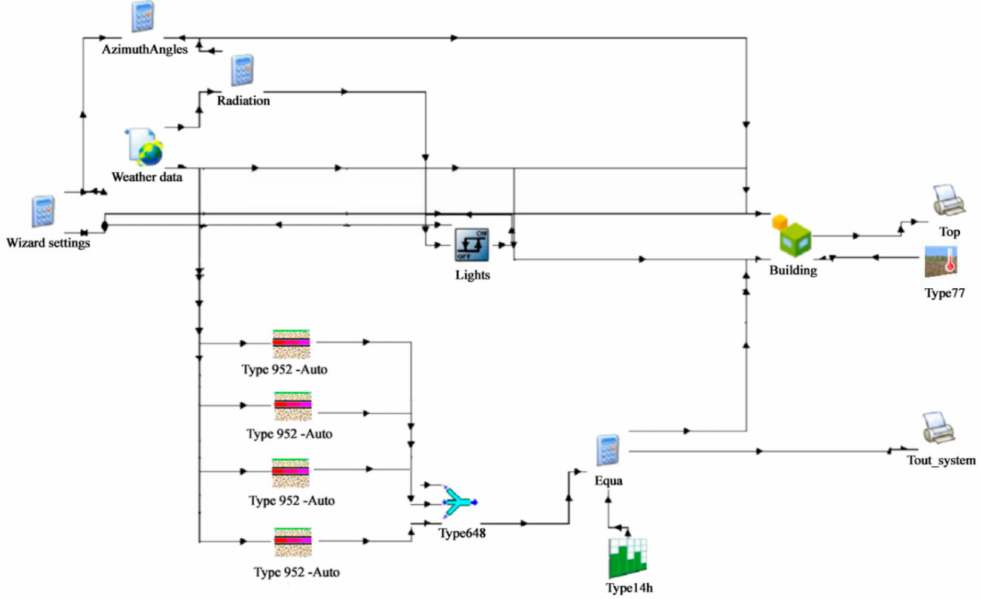
Figure 1. TRNSYS 17 simulation scheme for building energy